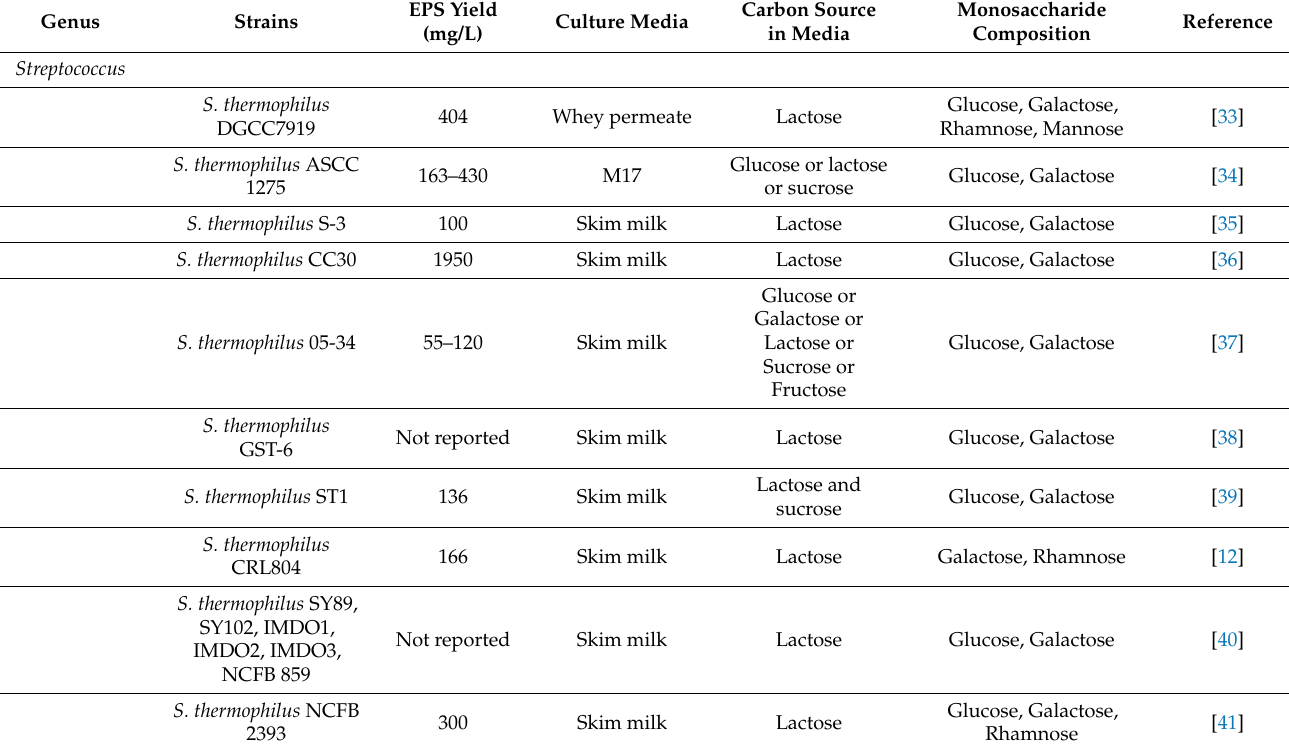
Table 2. Exopolysaccharide produced by some LAB strains growing in different media, carbon source and its monosaccha- ride composition.